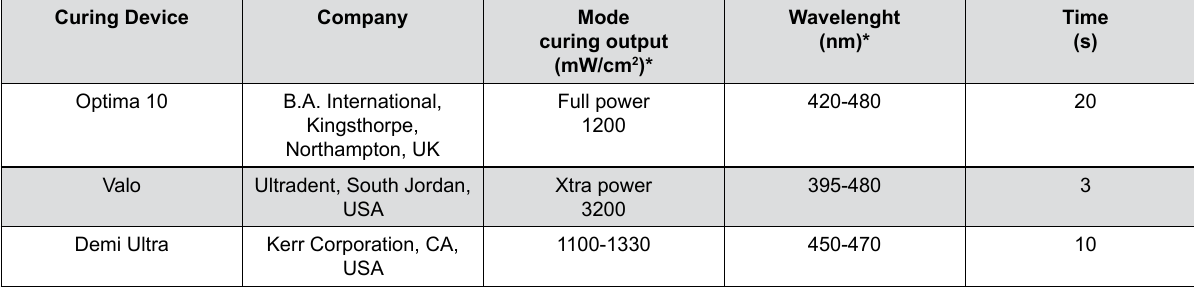
Figure 1- Properties of the bulk-fill giomer resin investigated Curing